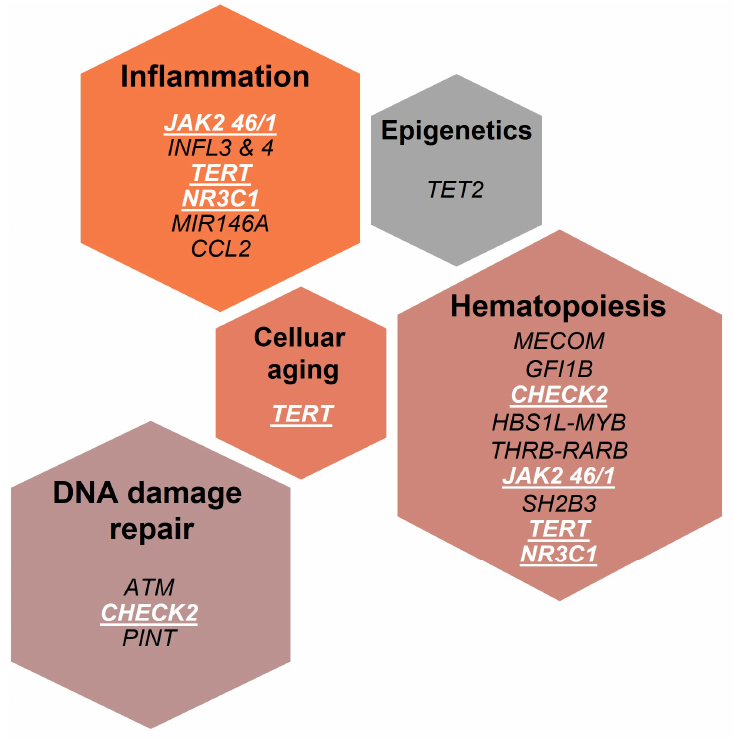
Figure 1. Germline variants associated with MPN risk, phenotype, outcome, and therapy response classified according to their biological function. Genes exerting multiple functions are highlighted in